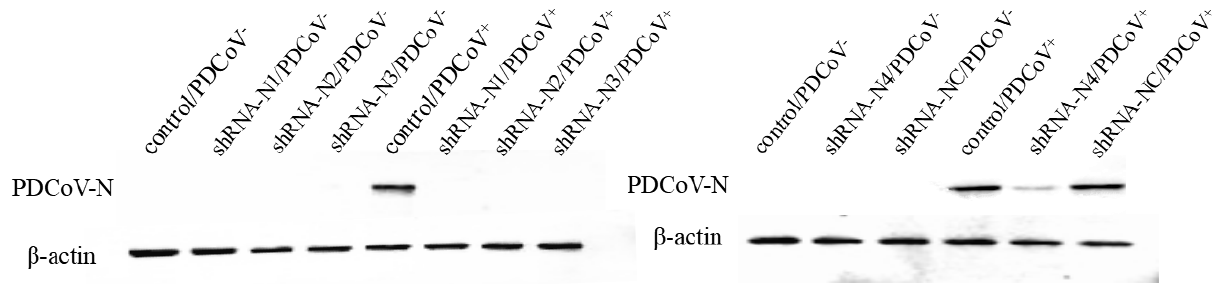
Figure 2. Expression of the N protein of PDCoV assessed by Western blotting. Equal amounts of cell lysates of PDCoV-infected/non-infected LLC-PK1 cells harvested at 36 hpi were tested using anti-PDCoV polyclonal antibodies (1:50 diluent), with β -actin as a protein reference control.